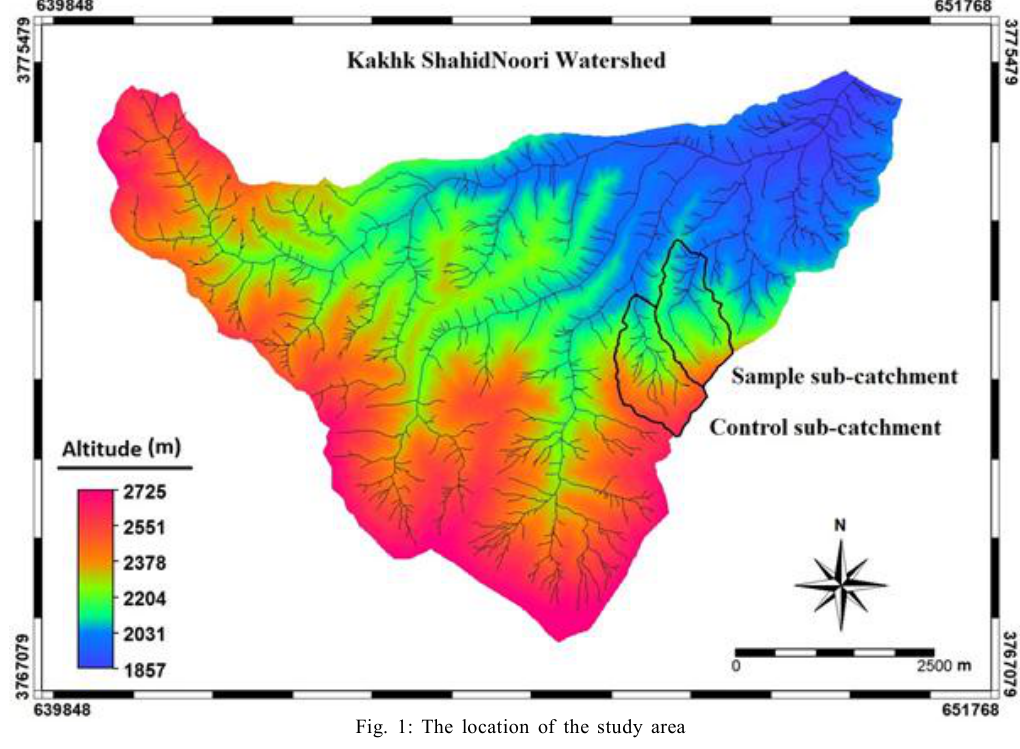
Fig. 1: The location of the study area